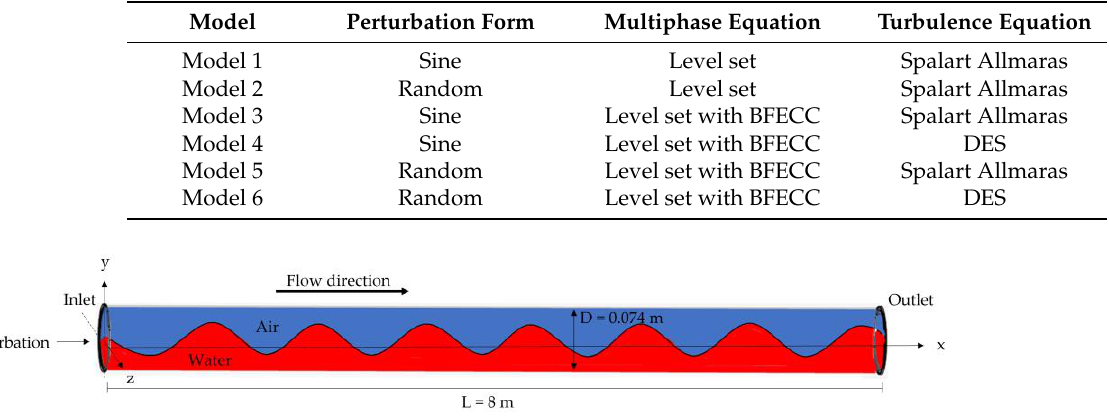
Figure 1. Geometry of the pipe carrying two-phase fluid. Table 3. Fluid and gas properties employed in the simulation Table 2. Combinations of perturbations, multiphase and turbulence equations for each model.